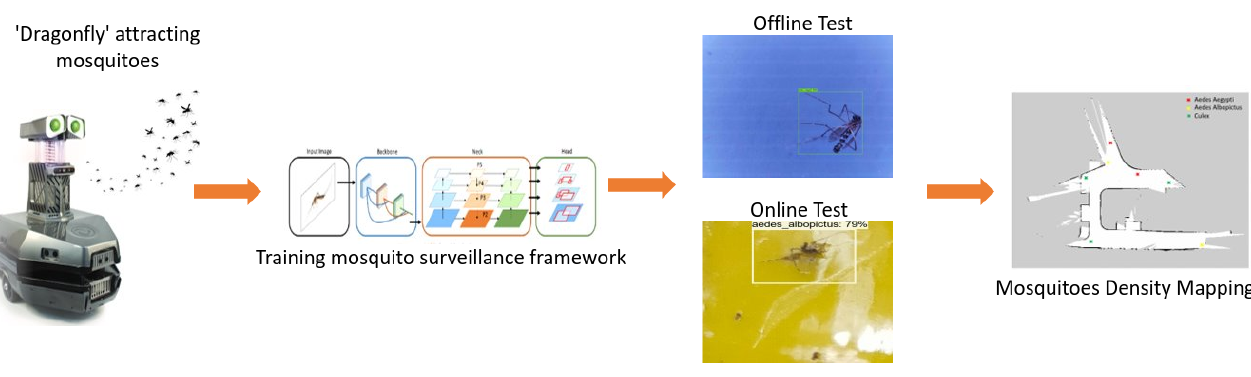
Figure 1. Overview diagram of proposed